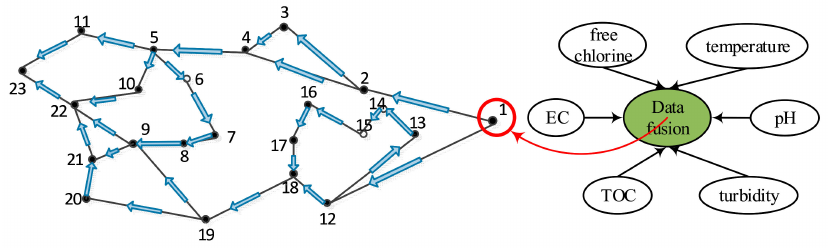
Figure 1. The topology of a water supply